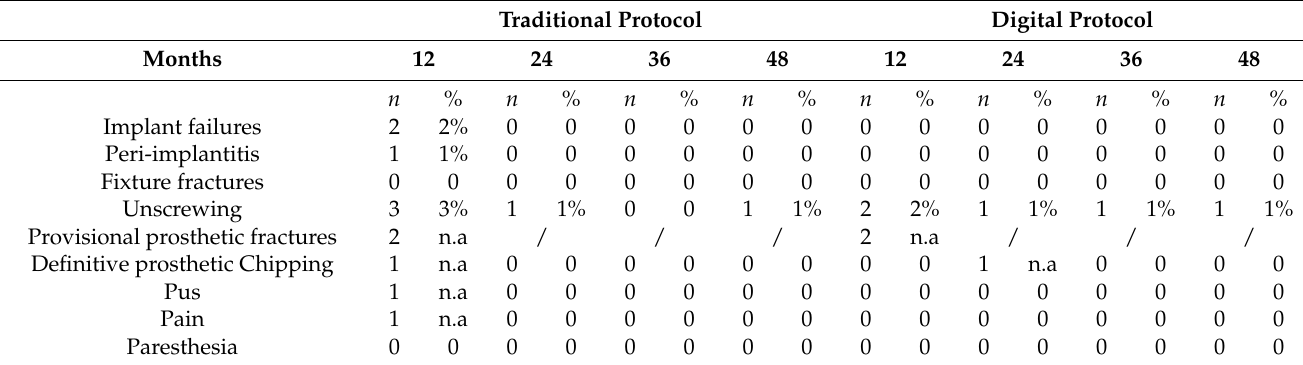
Table 3. Implant failure and